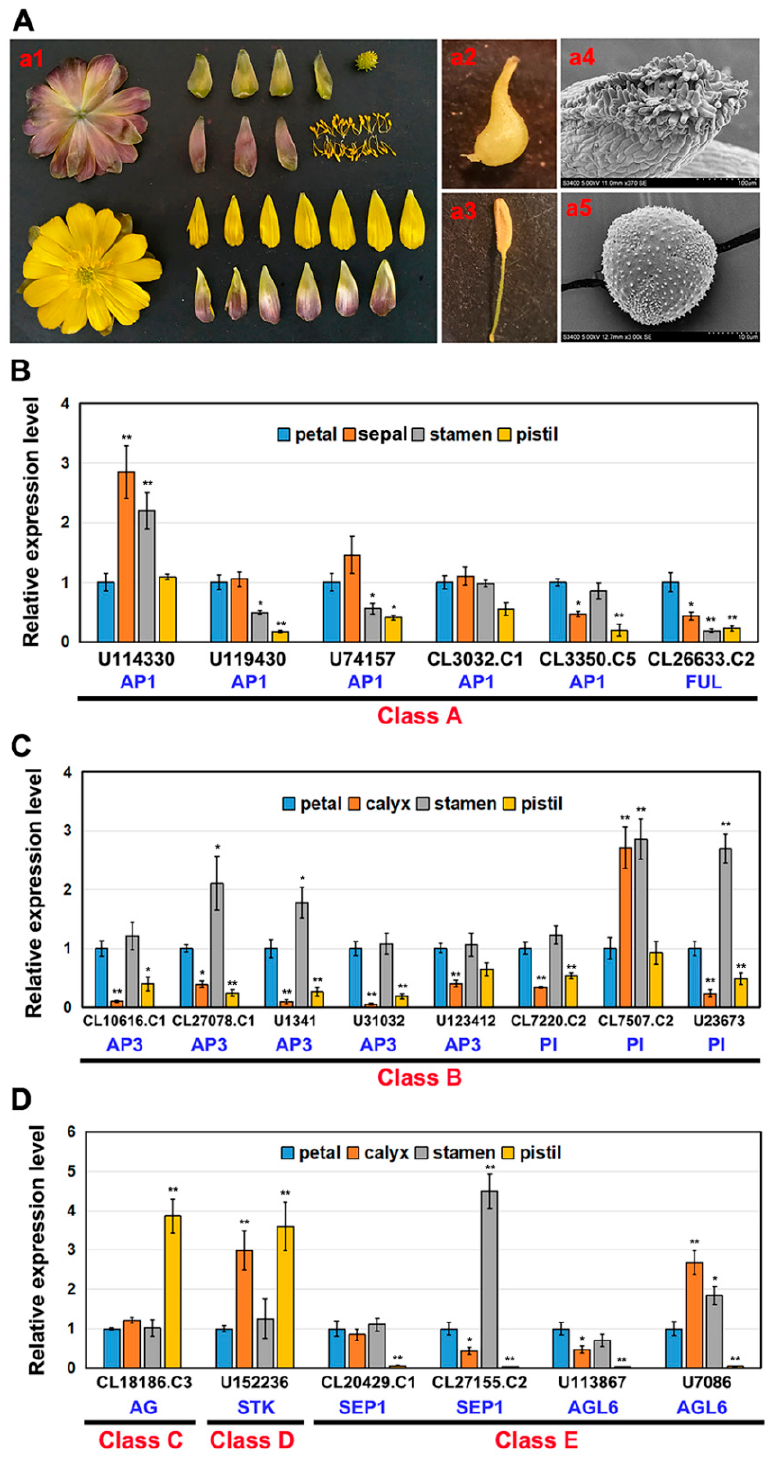
Figure 4. Organ-specific expression analysis of 20 AaMADS genes classified in the ABCDE model in the flower of A. amurensis . ( A ) The flower morphology and its anatomy, including petals, calyx, stamens, and pistils ( a1 ), simple pistil ( a2 ) and stigma ( a4 ), simple anther ( a3 ) and pollen grain ( a5 ). qPCR analysis of A-class ( B ), B-class ( C ), and C-, D-, and E-class ( D ) AaMADS gene expression in different flower structures. The AaActin gene was used as an internal control, and the transcript level in petals was set as 1.0. Asterisks indicate significant differences in gene expression levels between other tissues and petals (* p < 0.05; ** p < 0.01; Student’s t -test). Error bars represent the SE ( n = 3).